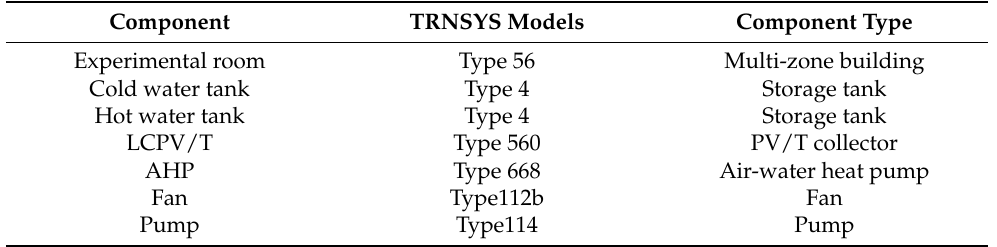
Table 2. TRNSYS models of system main